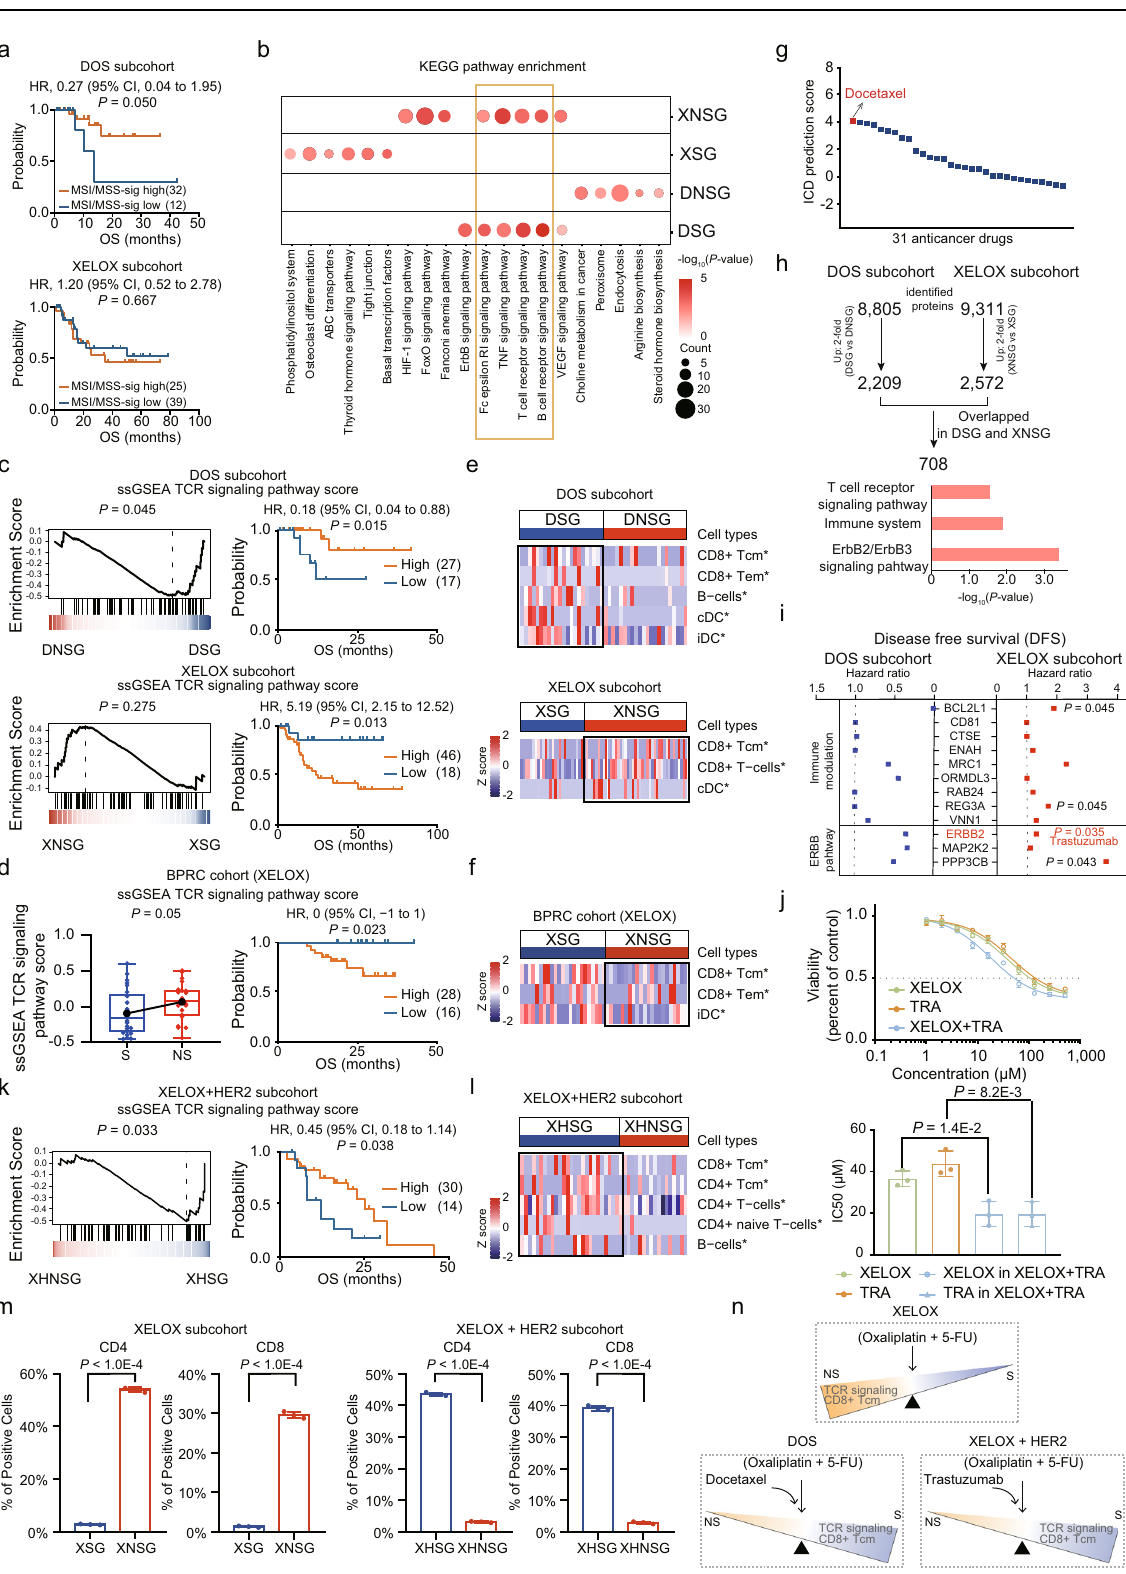
that GC patients with high TCR signaling are unlikely to bene fi t from XELOX,butinsteadrespondtoXELOX+ anti-HER2.Takentogether,the combination of trastuzumab with XELOX therapy could resulted in a synergistic antitumor effect, and TCR signaling pathway and CD8 + Tcm emerged as a favorable response marker for the combination therapy (Fig.